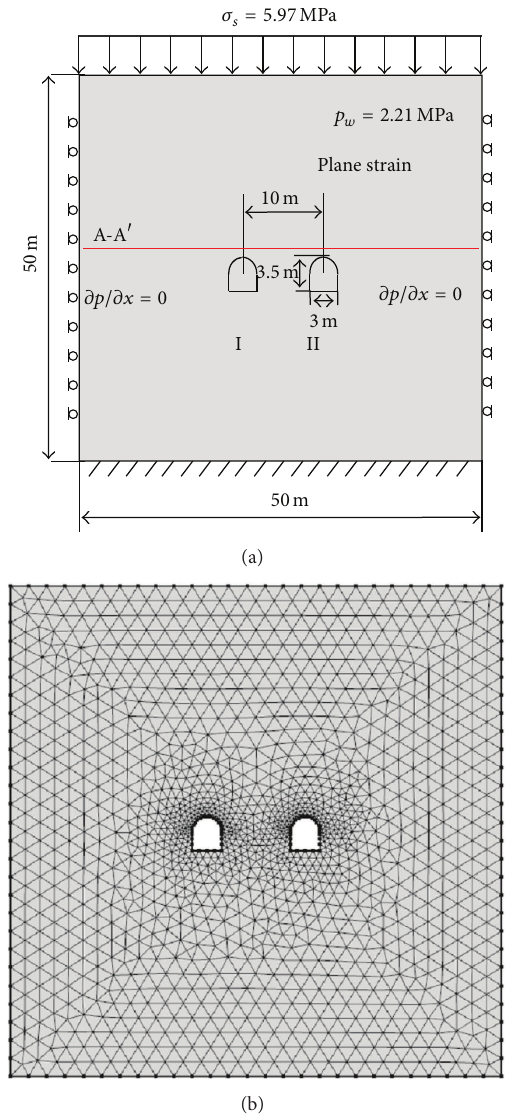
Figure 16: Plane strain roadway model: (a) boundary conditions; (b) the finite element mesh.